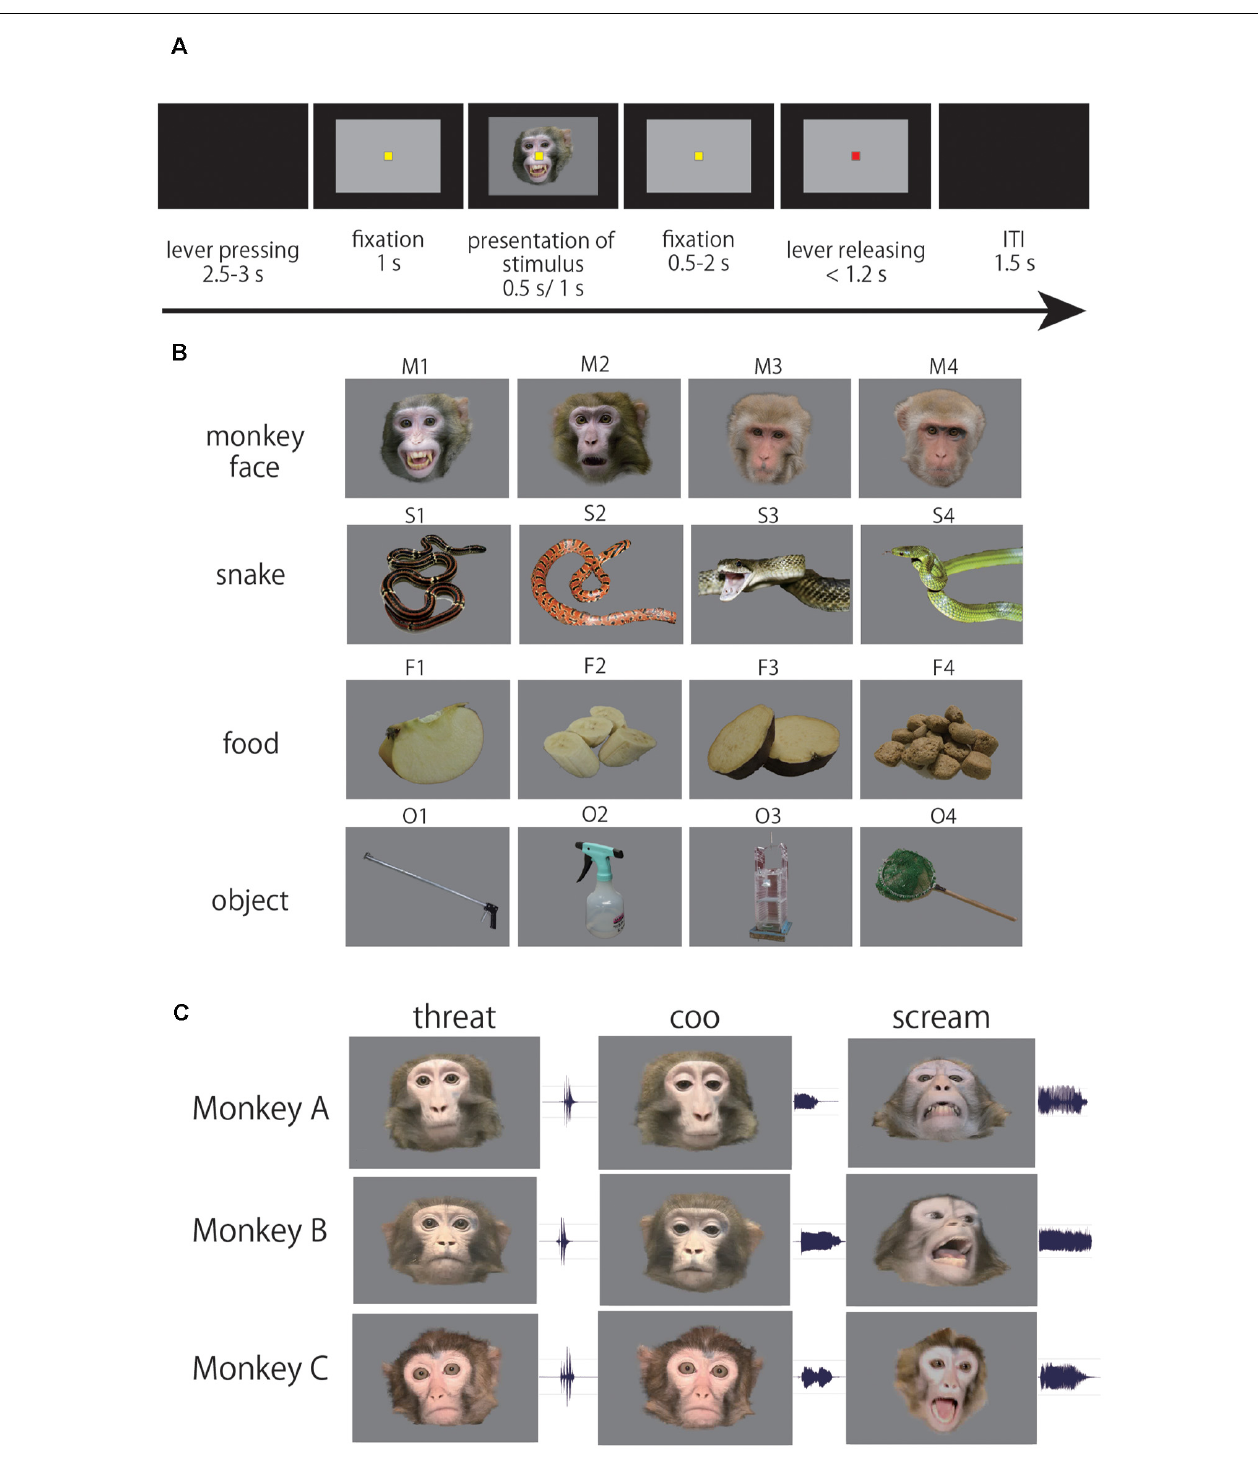
FIGURE 1 | (A) Sequence of events in the passive viewing task. When the monkey pressed a lever, a yellow fixation point (FP) appeared. After the monkey kept the lever pressed and fixated on the FP for 1.0 s, a photo stimulus was presented for 0.5 s, or a video clip was presented for 1.0 s. Thereafter, the yellow fixation point was replaced by a red point after a certain period (0.5–2 s). If the monkey released the lever within 1.2 s of the replacement, the trial was regarded as correct. (B) Photo stimuli. The photo stimulus set consisted of 16 stimuli (four photos of four categories; monkey faces, snakes, foods, and artificial objects). (C) Video stimuli. The video stimulus set consisted of nine movie clips (three facial emotions of three monkeys; aggressive threat, coo, scream). Also, we used four videos of two human faces and two objects (camera and bell) as control stimuli (Kuraoka and Nakamura, 2006, 2007).